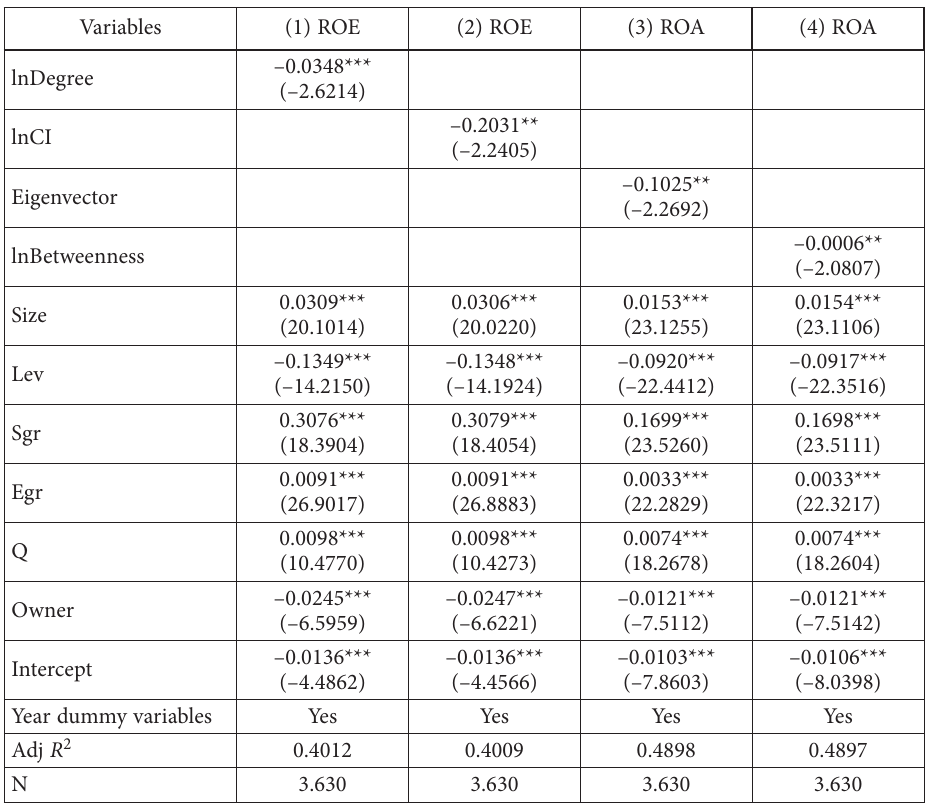
Table 4. Robustness test